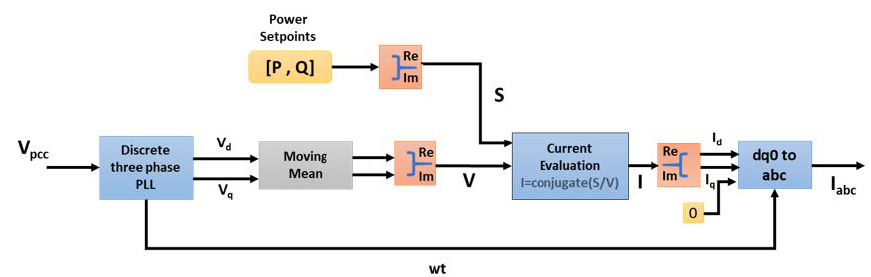
Figure 8. Reference current evaluation for current-controlled (CC)-amplifier based on voltage at the point of common coupling (PCC) and desired power set-points.